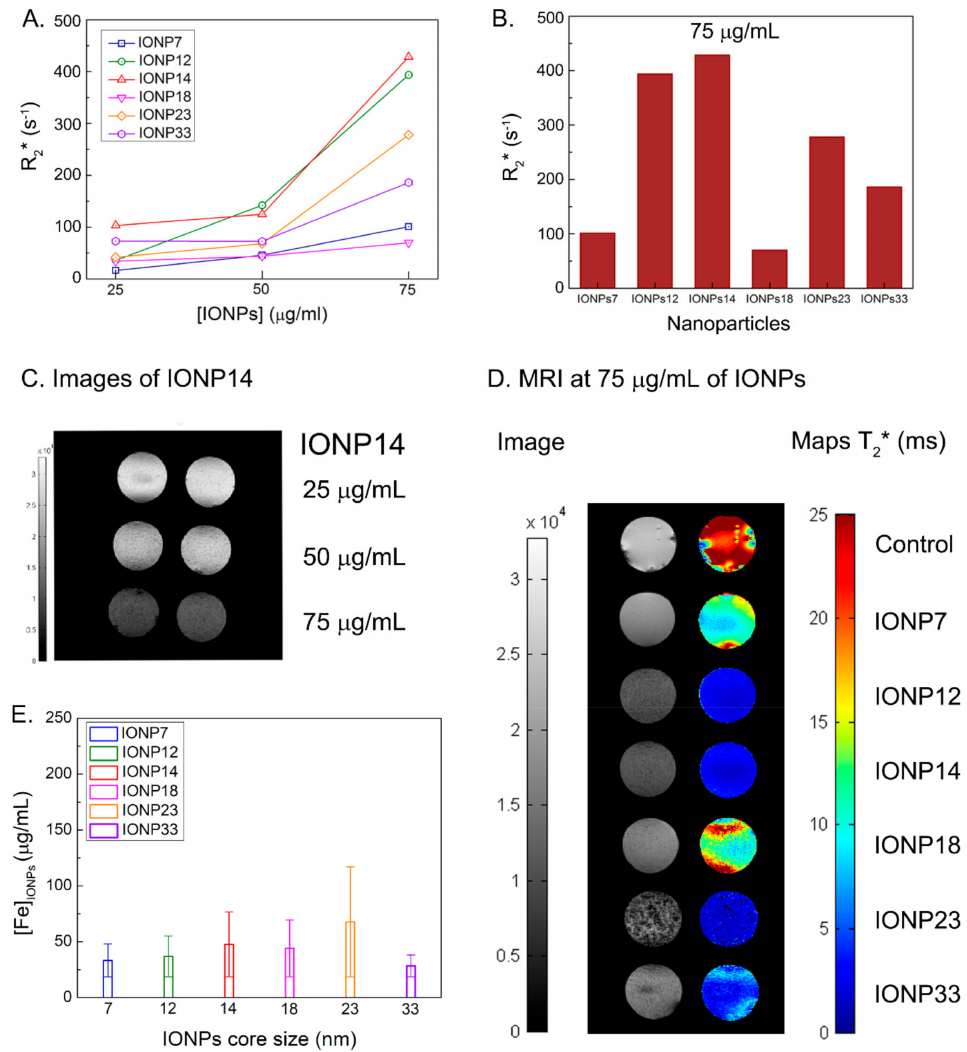
Figure 5. ( A ) R 2* values at three different IONPs concentrations for all the core NPs sizes. ( B ) R 2* values of all IONPs at a concentration of 75 µ g/mL. See the highest values for IONP14 and IONP12. ( C ) Duplicate contrast images of all IONPs at an initial concentration of 75 µ g/mL of IONP14 show a better contrast when increasing the concentration of IONPs. ( D ) Contrast and T 2* maps of all IONPs at a concentration of 75 µ g/mL. ( E ) Intracellular iron concentration after CMI method measured by Prussian blue staining images using 75 µ g/mL of